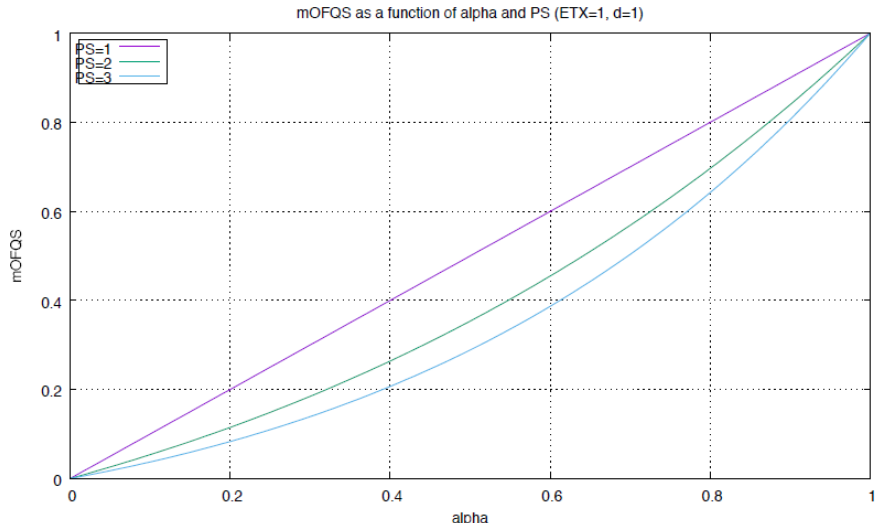
Figure 3. mOFQS variation with α .